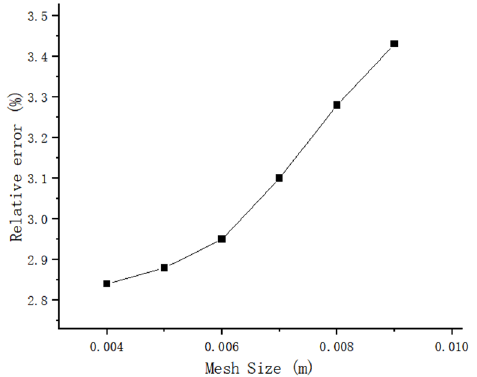
Figure 3. Mesh sensitivity analysis.